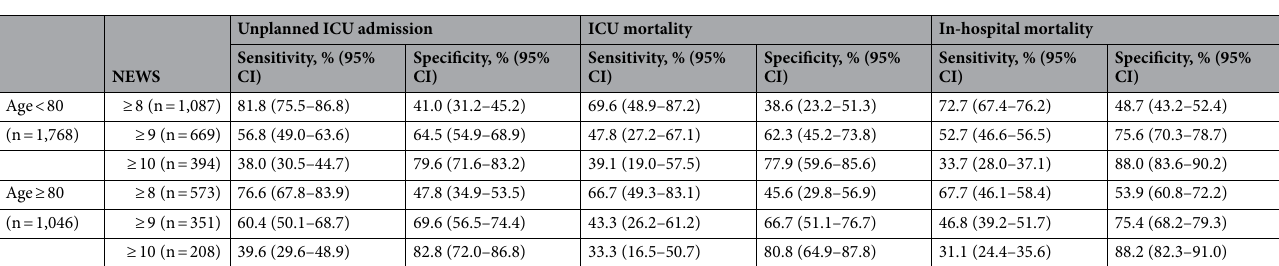
Table 2. Accuracy of the National early warning score for severe outcomes in high-risk patients by age group. NEWS National early warning score, ICU intensive care unit, CI confidence